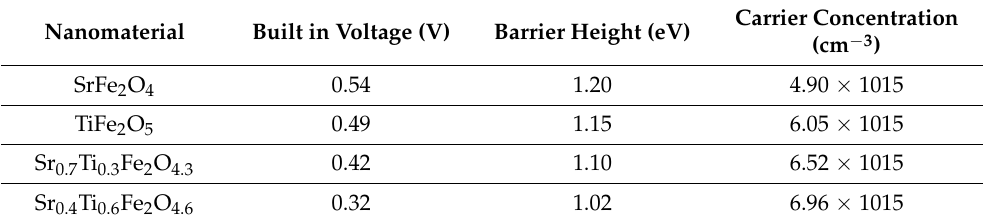
Table 4. C-V parameters of Al/SrFe 2 O 4 , TiFe 2 O 5 , Sr 0.7 Ti 0.3 Fe 2 O 4.3 and Sr 0.4 Ti 0.6 Fe 2 O 4.6 ferrite Schot- tky